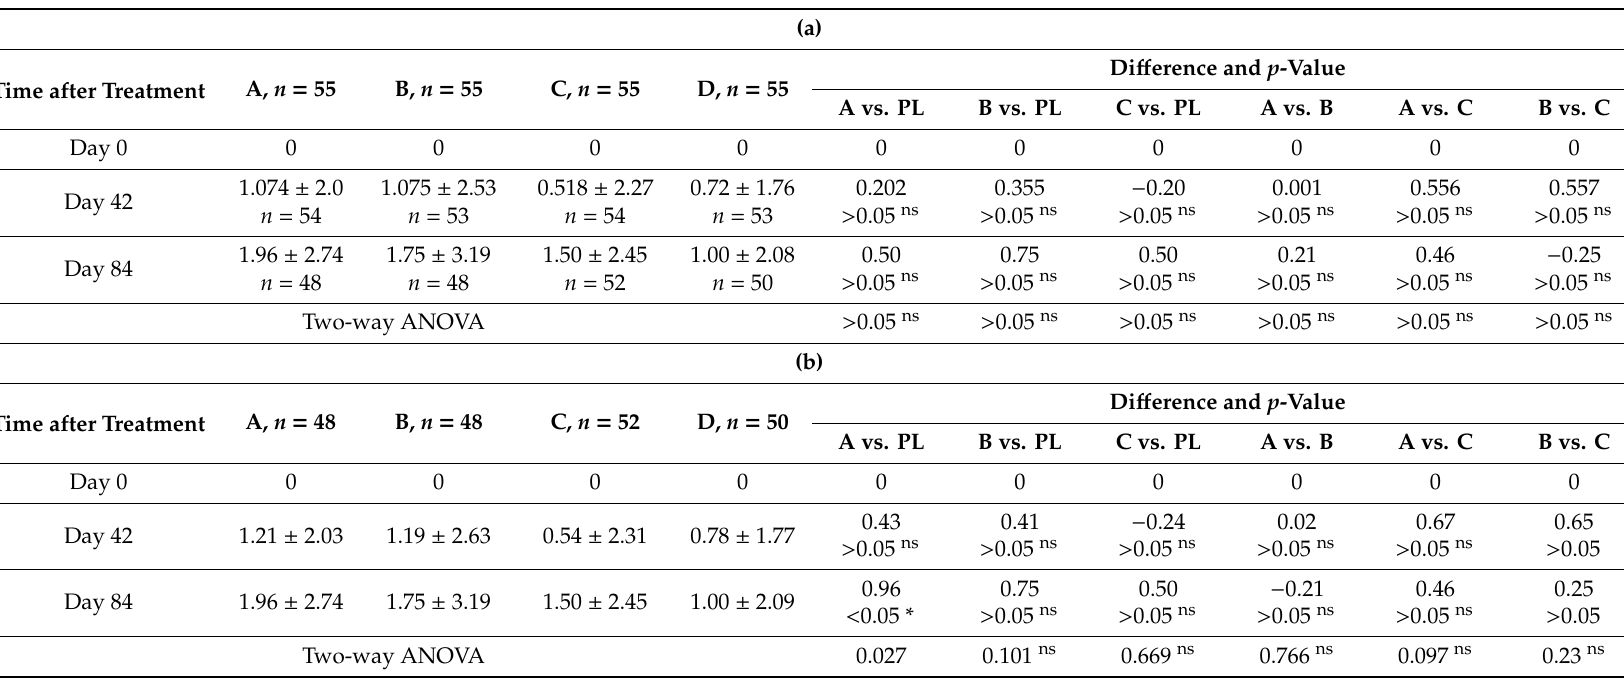
Table A7. ( a ). The change from baseline of UQOL sexual activity score (mean ± SD) over time. All patients including dropouts—ITT analysis. ( b ). The change from baseline of UQOL sexual activity score (mean ± SD) over time. Patients completed the treatment and all tests, dropouts excluded—PP